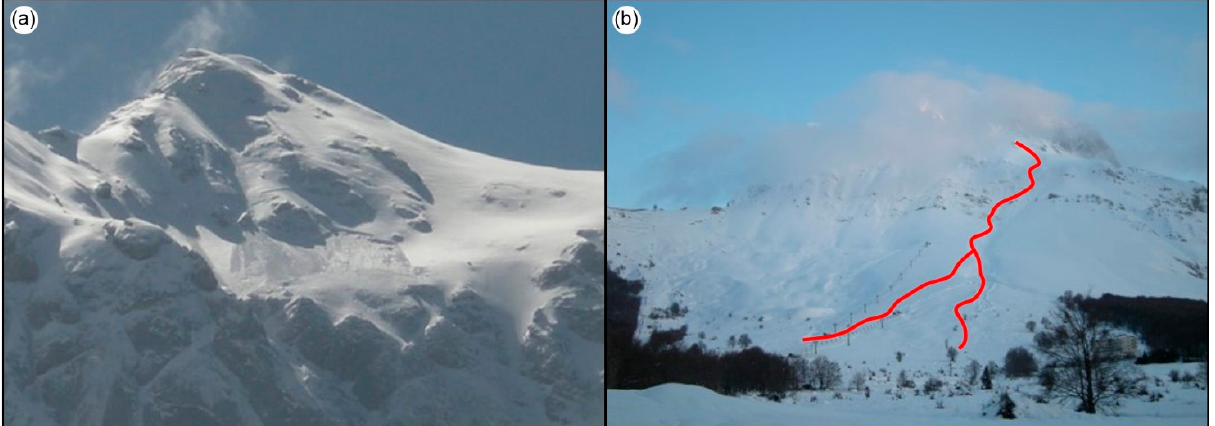
Figure 16. Photo documentation of the snow avalanches of March 2020. ( a ) Evidence of the summit detachment area at the base of Corno Piccolo with a clear surface slab and ( b ) a simplified snow avalanche path (in red) affecting the Vallone della Giumenta and involving the main ski facilities.